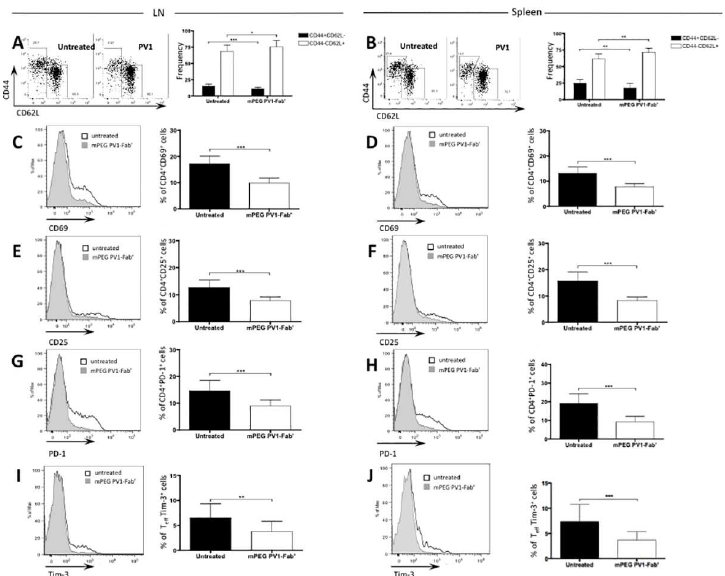
Fig 3. PV1-treated mice exhibited a decreasein overallactivation of T lymphocytes. B10.RIII micewere immunized with 50 μ g/animalof 161–180 IRBP in CFA, plus500ng/animalof PTx boost. Starting on day 9, mice weretreatedevery 4 dayswith CD28antagonist, PV1 (10mg/Kg;ip), or left untreated. On day14 micewere sacrificedandspleenanddLNwerecollectedfor immunophenotyping.(A) Representative plot for CD44and CD62Lexpressionin T CD4 + lymphocytes, andfrequencies of CD44 + CD62L - (effector) andCD44 - CD62L + (na ï ve)CD4 + T lymphocytesin dLN and(B) spleen.(C) Representative plot for expression of CD69in CD4 + lymphocytes andfrequencyof CD4 + CD69 + T cellsin dLNand(D) spleen.(E) Representative plot for expression of CD25in CD4 + lymphocytes andfrequencyof CD4 + CD25 + T cellsin dLN and(F) spleen.(G) Representative plot for expression of PD-1 in CD4 + lymphocytes andfrequencyof CD4 + PD-1 + T cellsin dLN and(H) spleen. Datacombinedfrom threeindependent experiments; 5 miceper group.Representative plot for expression of Tim-3 in CD4 + CD44 + CD62L - lymphocytes andfrequencyof CD4 + CD44 + CD62L - Tim-3 + T cellsin (I) dLNand(J) spleen.Data combinedfrom three independent experiments; 5 mice per group.Mean ± SD are depicted. * , p < 0.05; ** ,p < 0.01; *** ,p < 0.0001, two-tailedMann-Whitney test.